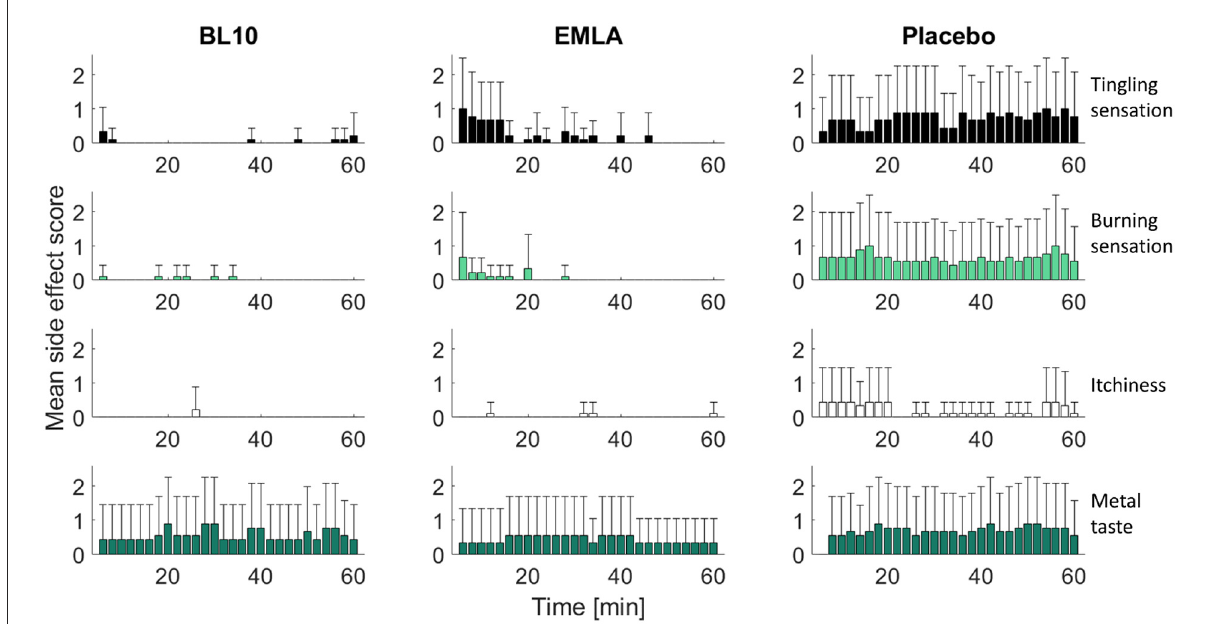
FIGURE4 Effect of topical anesthetic gels on tDCS side effects. The side effects are shown as the mean side effect scores for nine subjects in time with the error bars indicating the standard deviation. In general, subjects experienced less side effects for the BL10 and EMLA gel compared to placebo. For the placebo gel, the most commonly reported side effects were: tingling sensation, burning sensation, itchiness and metal taste while other side effects were reported much less frequently. For the BL10 and EMLA gel, tingling sensation, burning sensation and itchiness were reduced compared to placebo, while the scores for metal taste were not influenced by the anesthetic gels. Although both anesthetic gels reduced sensations in the scalp, the sensations for the EMLA gel remained relatively high in the beginning of the experiment compared to the BL10 gel. An overview of all side effects is given in the Supplementary